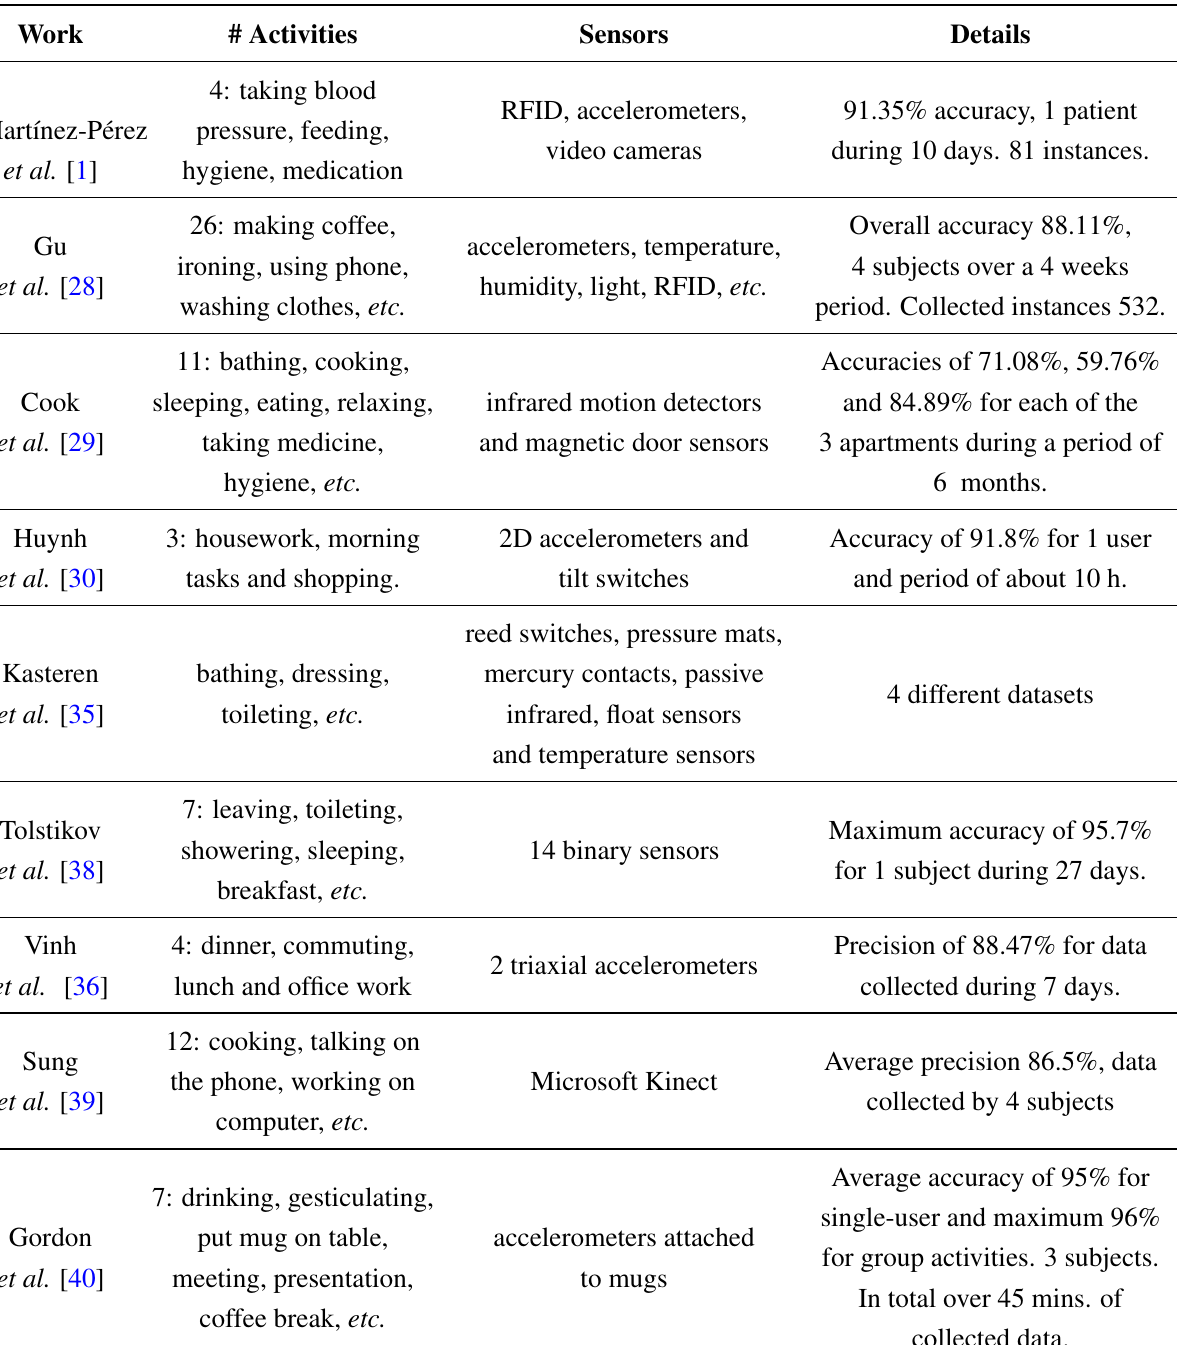
Table 1. Related complex activity recognition